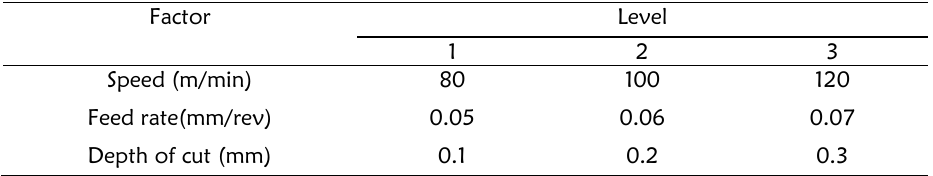
Table 2: Machining Parameters for Experiments